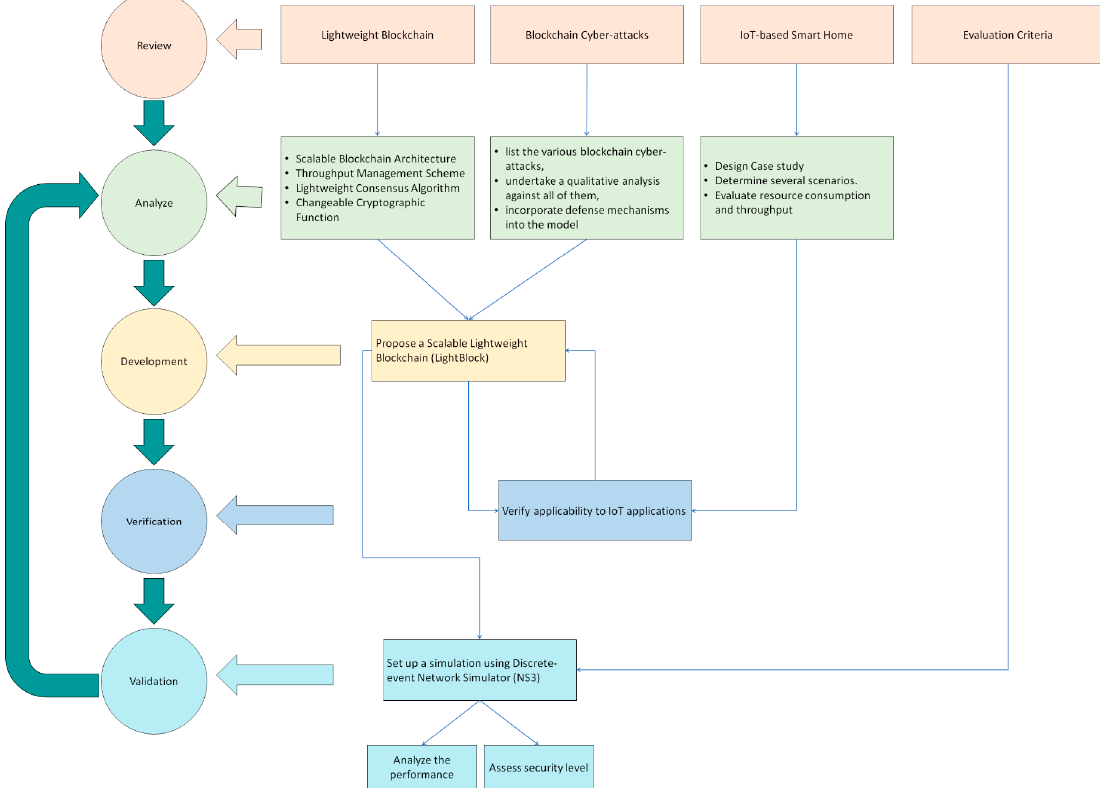
Figure 1. Development methodology.